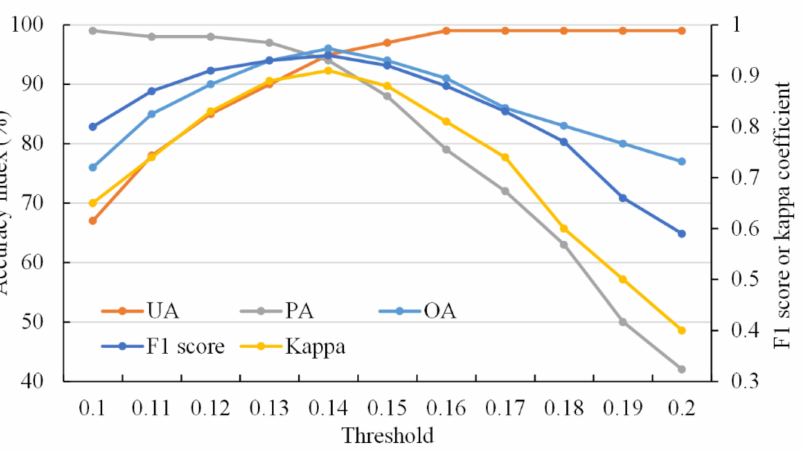
Figure 6. Classification accuracy for various thresholds based on CFI images derived from Sentinel- 2 images on 20 March 2020 in the first study area. UA = user accuracy of canola category, PA = production accuracy of canola category, OA = overall